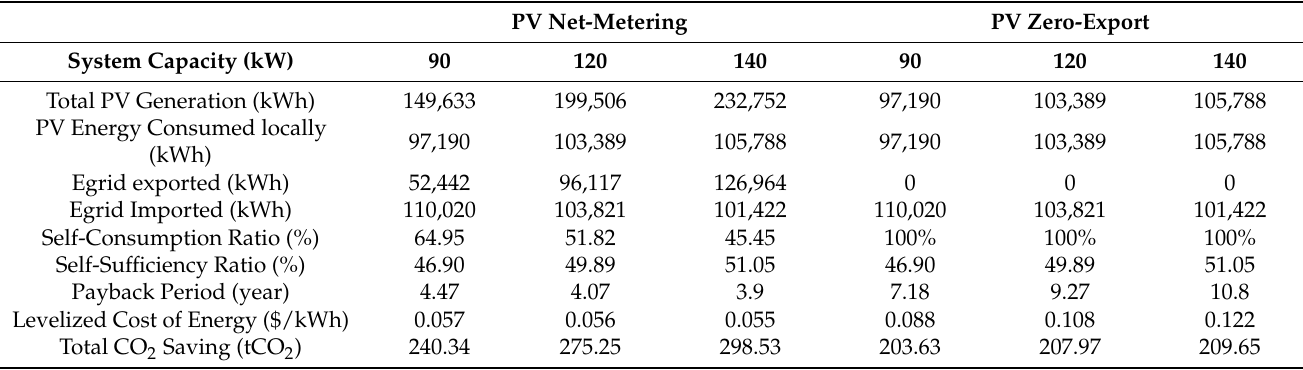
Table 7. Performance of EV charging station with PV system without battery. PV Net-Metering